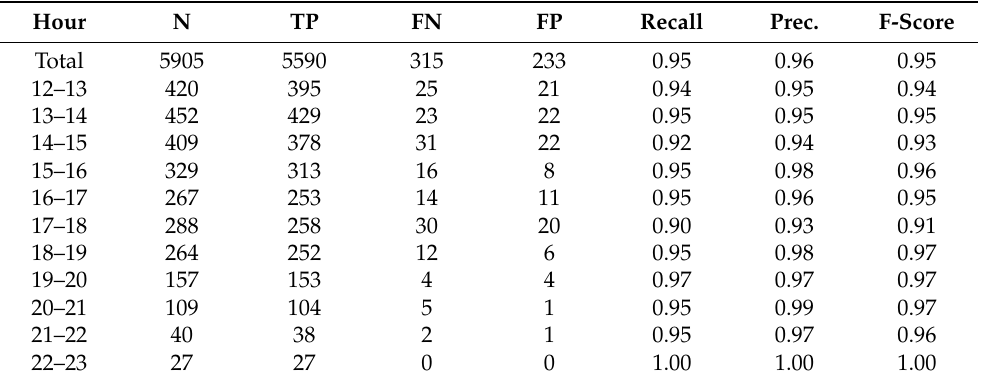
Table 1. Vehicle detection results: the total result for the 24-h observation and the results for one-hour time slots. N is the number of vehicles according to the reference